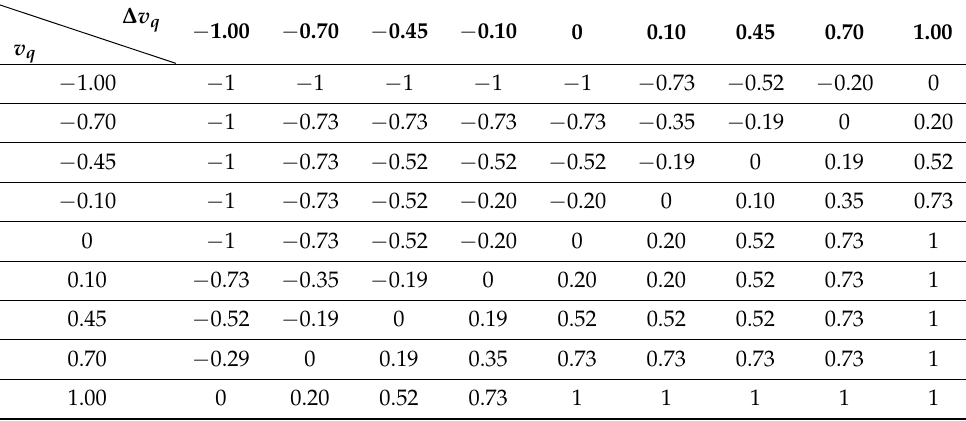
Table 1. The rules for the fuzzy correction